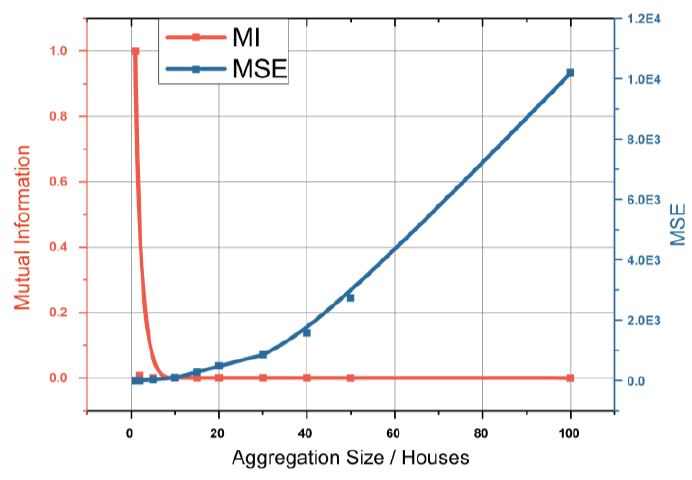
Figure 6. Mutual information and MSE of different aggregation sizes.